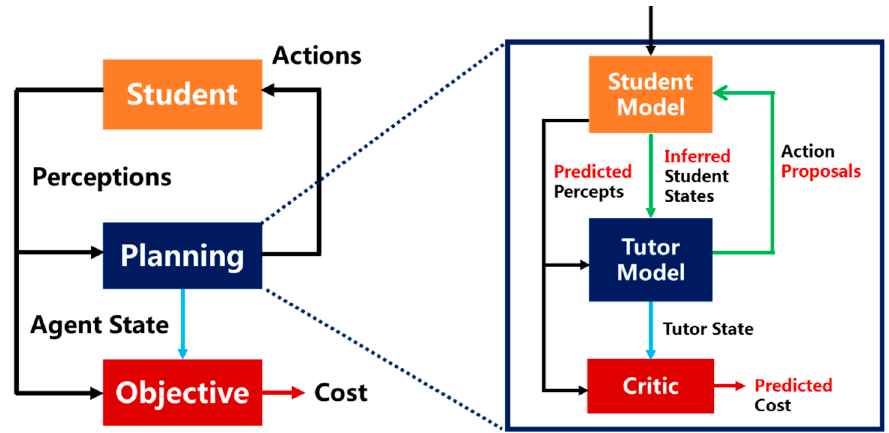
Figure 4. Illustrations of internal models of the planning module.